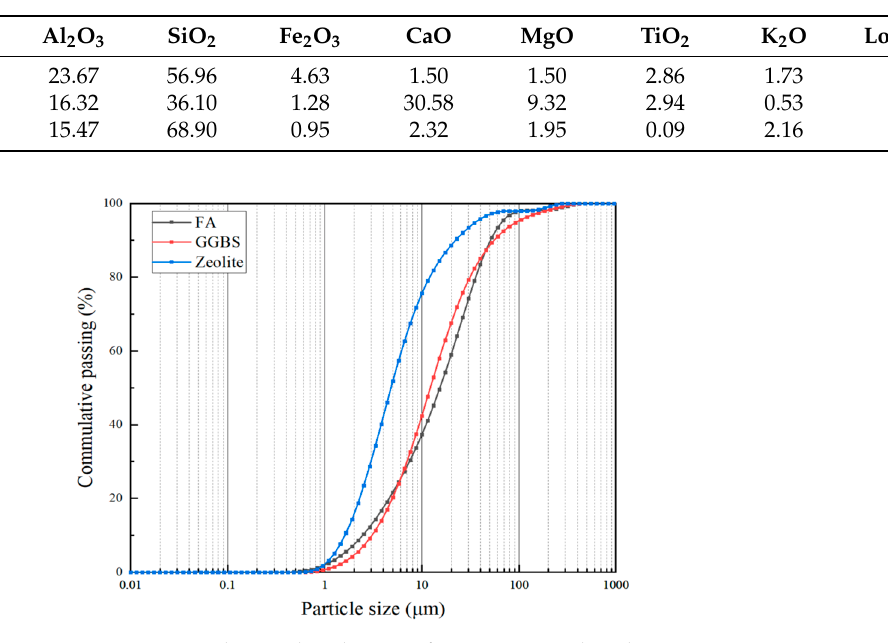
Table 1. Chemical compositions of FA, blast furnace GGBS, and zeolite powder (wt%).